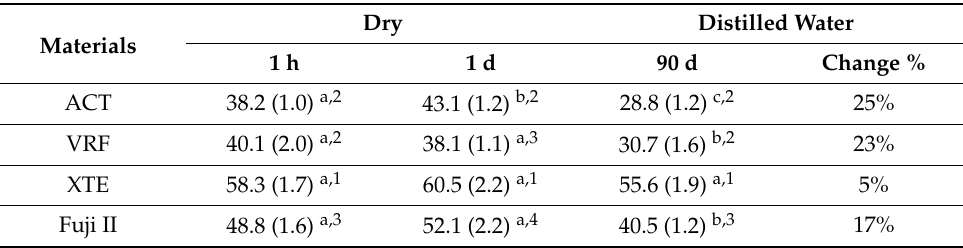
Table 2. VHN values (mean and standard deviation) for each type of material with respect to storage time.